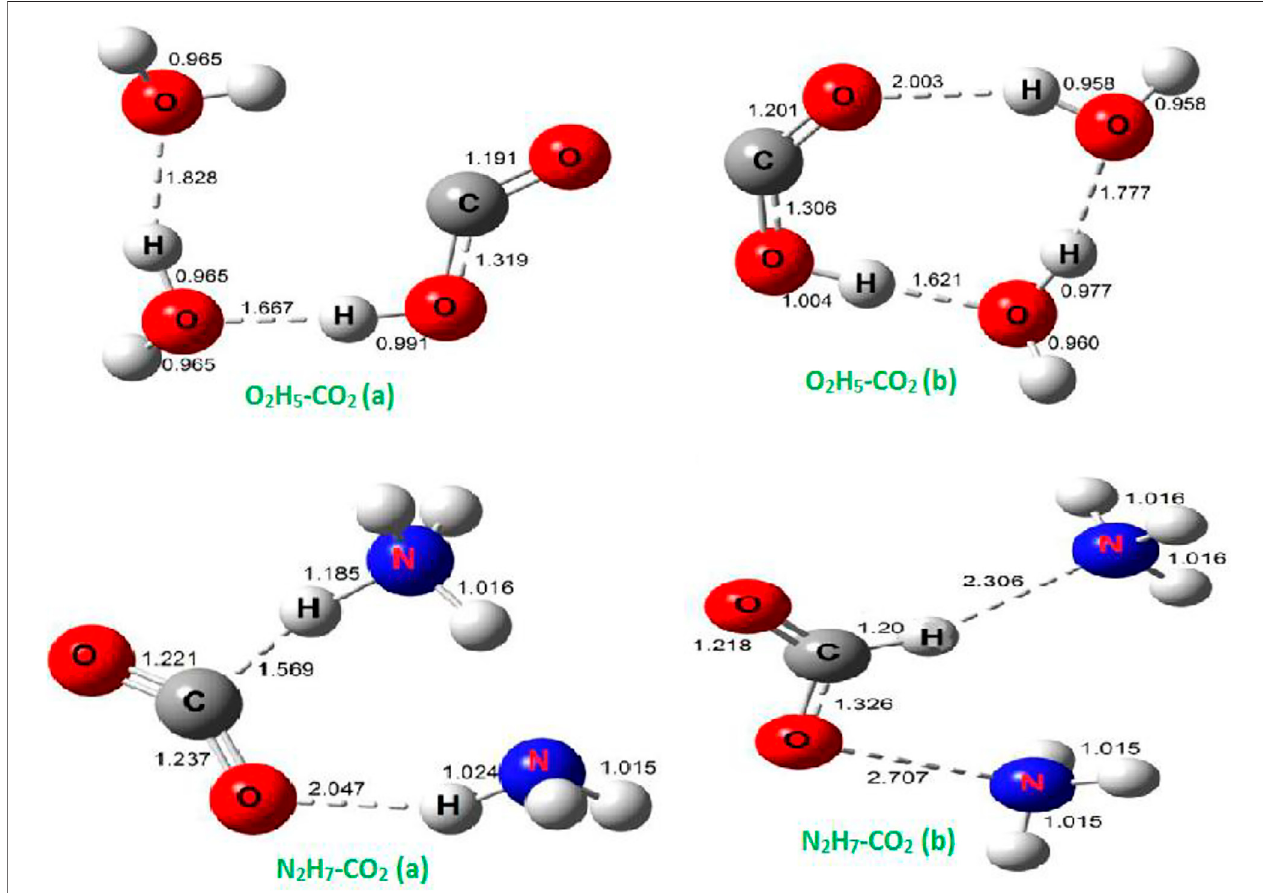
FIGURE 6 | Equilibrium structures of CO 2 complexes with non-metallic superalkalis from Ref. 42 with the permission of the Taylor & Francis.